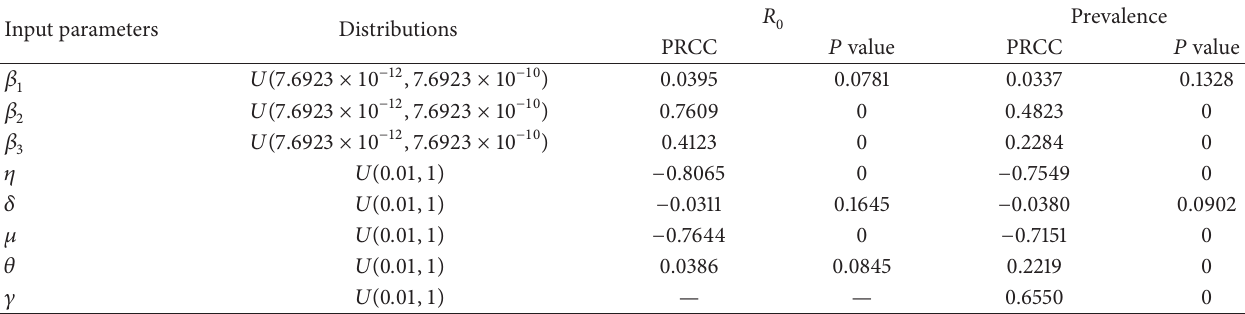
Table 2: PRCC values for 𝑅 0 and prevalence at endemic